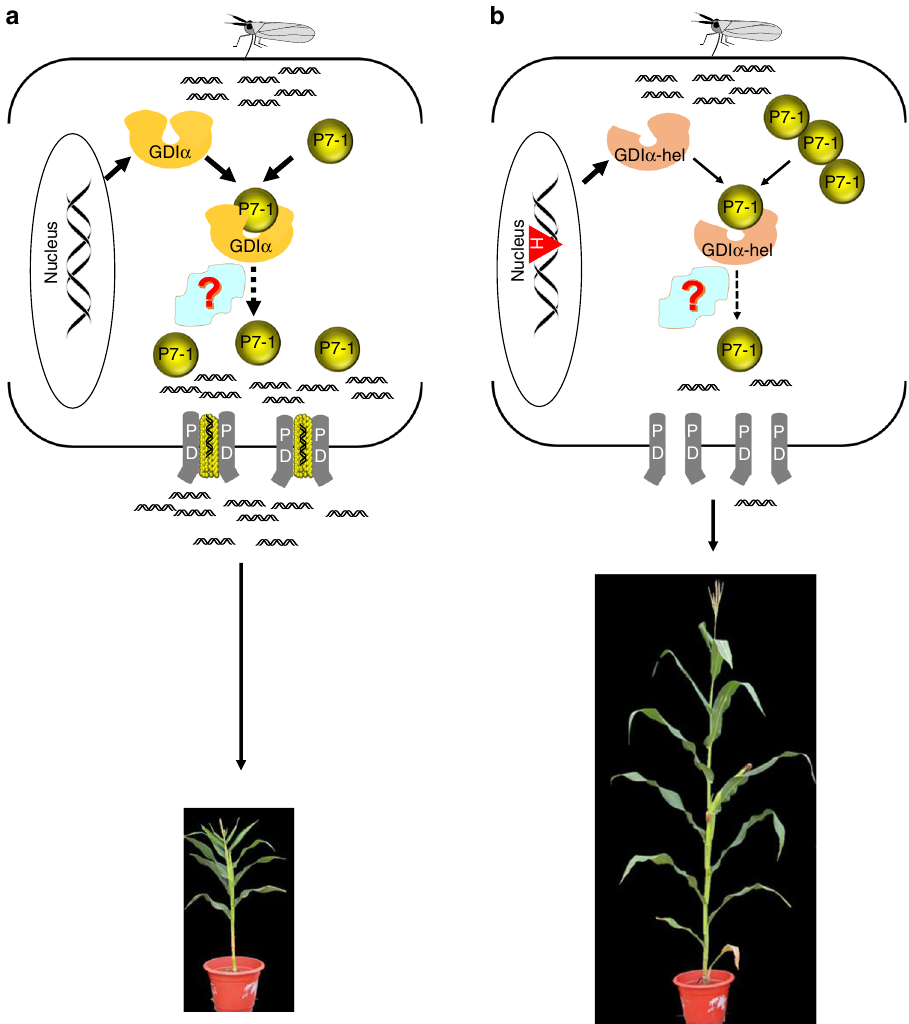
Fig. 6 A working model of the RabGDI/RabGDI-hel in maize resistance to RBSDV. There was a quantitative difference in binding of the viral P7-1 proteins by the two protein isoforms RabGDI and RabGDI-hel, which is associated with the quantitative resistance to RBSDV. a In wild-type maize, viral P7-1 protein (olive circle) recruits host RabGDI α (gold horseshoe) to form a potential traf fi cking complex for plasmodesmata (PD, gray) targeting. P7-1 proteins form virus-containing tubules to assist viral intercellular movement and dissemination, resulting in maize susceptible to RBSDV. Black double helix: viral dsRNA. b Viral P7-1 protein has dif fi culty at recruiting RabGDI α -hel (lightsalmon horseshoe) due to its weak binding to the helitron- induced exon 10 peptide, and this compromises PD targeting and viral intercellular movement and dissemination, ultimately leading to quantitative recessive resistance to RBSDV. Red triangle with H indicates helitron